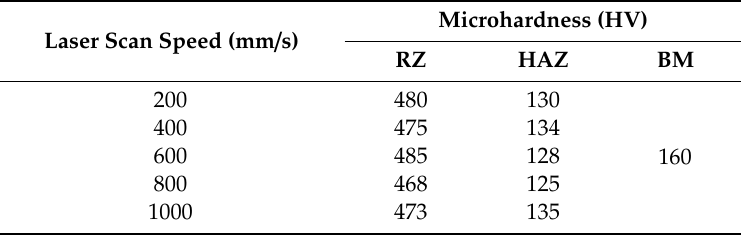
Table 5. Vickers microhardnesses of cold sprayed Ti coatings at different zones after laser re-melting with different laser scan speeds (adapted from reference [81], with permission from © Elsevier).